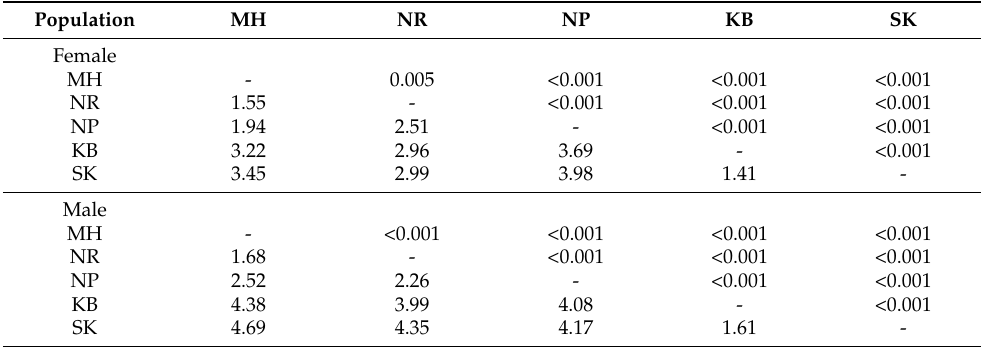
Figure 6. Factor maps based on discriminant analysis in wing shape variation of female ( top ) and male ( bottom ) S. calcitrans populations. Each point in a polygon represents an individual wing sample, and small squares in a polygon represent the position of the mean group. The horizontal axis was the first DF ( DF1 ) , whereas the vertical axis was the second DF ( DF2 ). Table 3. Mahalanobis distances (below diagonal) and p -values (above diagonal) among the wing shapes of female and male S. calcitrans populations.